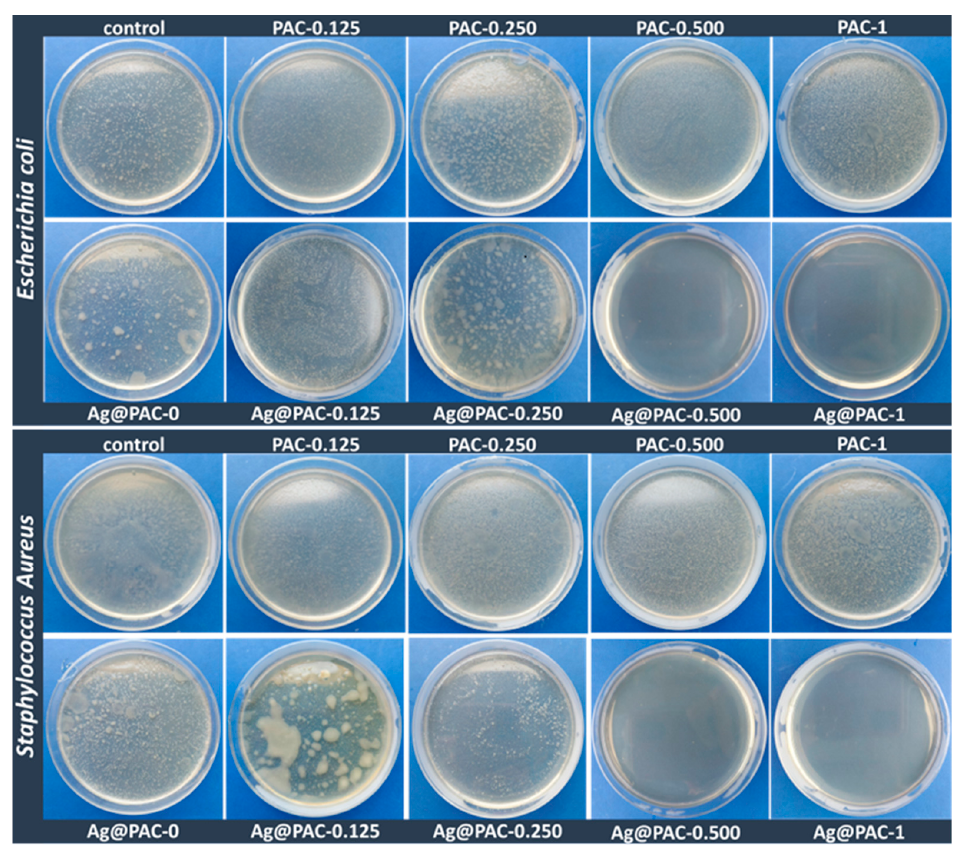
Figure 7. Antimicrobial efficiency of the Ag@PAC series compared to PAC counterparts. Table 4. Silver content (% wt./wt. with respect to the total solid content) and antibacterial efficiency of the PAC and Ag@PAC series against Gram-negative ( E. coli ) and Gram-positive ( S. aureus ) sam- ples.